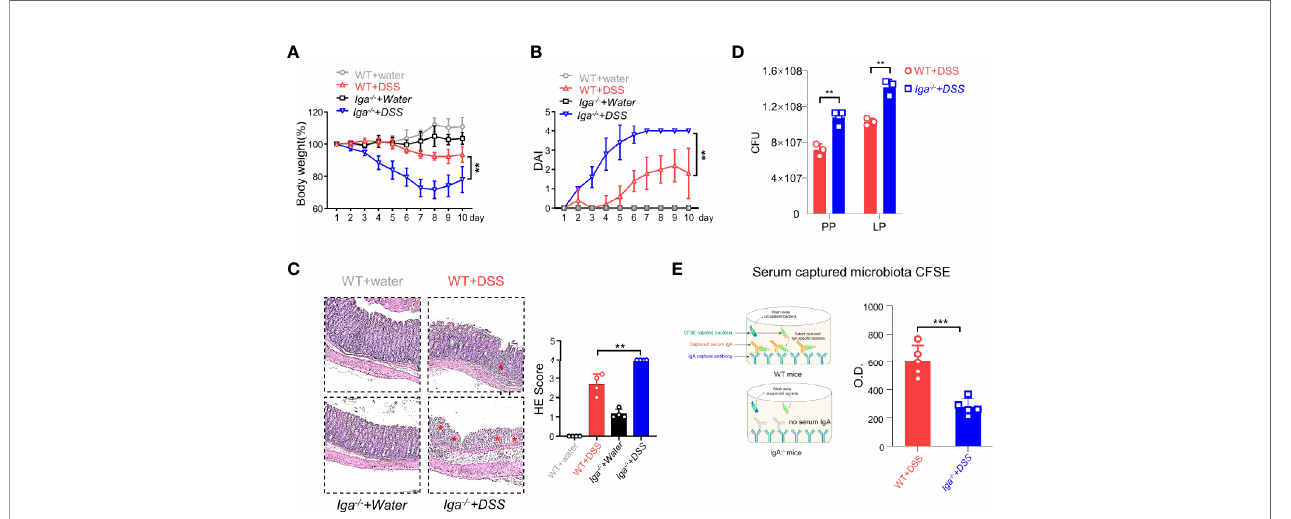
FIGURE 3 | IgA in DSS-induced colitis. (A) Iga − / − mice and WT mice were administered DSS or regular water (water). Mice were evaluated daily, and weight loss and disease activity index (DAI) scores (B) were recorded. (C) Representative distal colon histological sections of Iga − / − mice were stained with hematoxylin and eosin (H&E), and the histological score was calculated. Images are presented at the original magni fi cation of ×100. Red stars indicate the position of the in fl ammatory cell in fi ltration and/or epithelial damage. (D) The colony-forming units (CFU) counts of the bacteria in the feces of WT mice or Iga -/- mice on day 7 of colitis. (E) The O.D. values which indicated bacteria captured by the serum antibodies of WT mice or the Iga -/- mice on day 7 after DSS intervention were measured. **P < 0.01, ***P < 0.001. Data are expressed as mean ± SEM of three